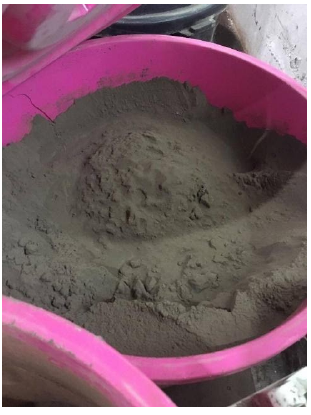
Figure 2. Air-dry processed spent bleaching earth (PSBE). Table 3. Chemical composition of PSBE and OPC.